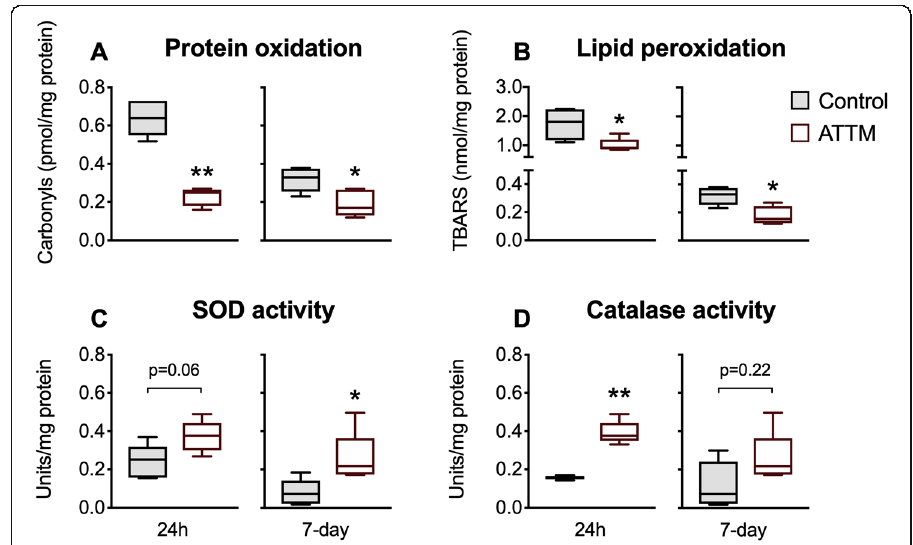
Fig. 5 Brain oxidative damage and anti-oxidant enzyme capacities. Oxidative damage to proteins and lipids measured by carbonyl and TBARS formation are shown in panels a and b , respectively. Enzyme activities of superoxide dismutase and catalase are shown in panels c and d , respectively. n = 5 per group. * p < 0.05, reactive